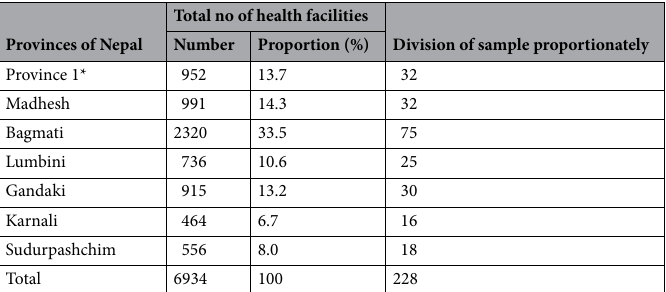
Table 1. Distribution of pharmacists among the seven provinces. * No name has been given to province 1 yet, as of 23rd April,